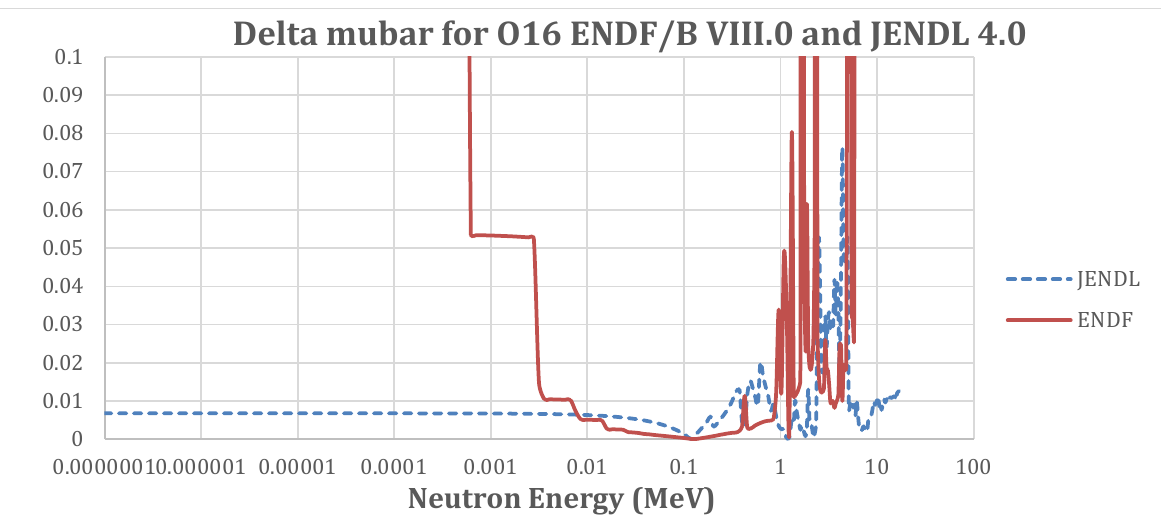
Figure 2. Comparison of mubar Uncertainties Between ENDF/B VIII.0 and JENDL 4.0 for